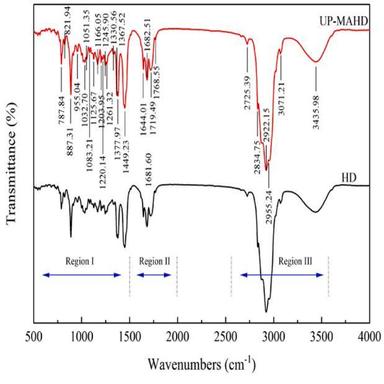
FT IR spectra of PKSSEO.